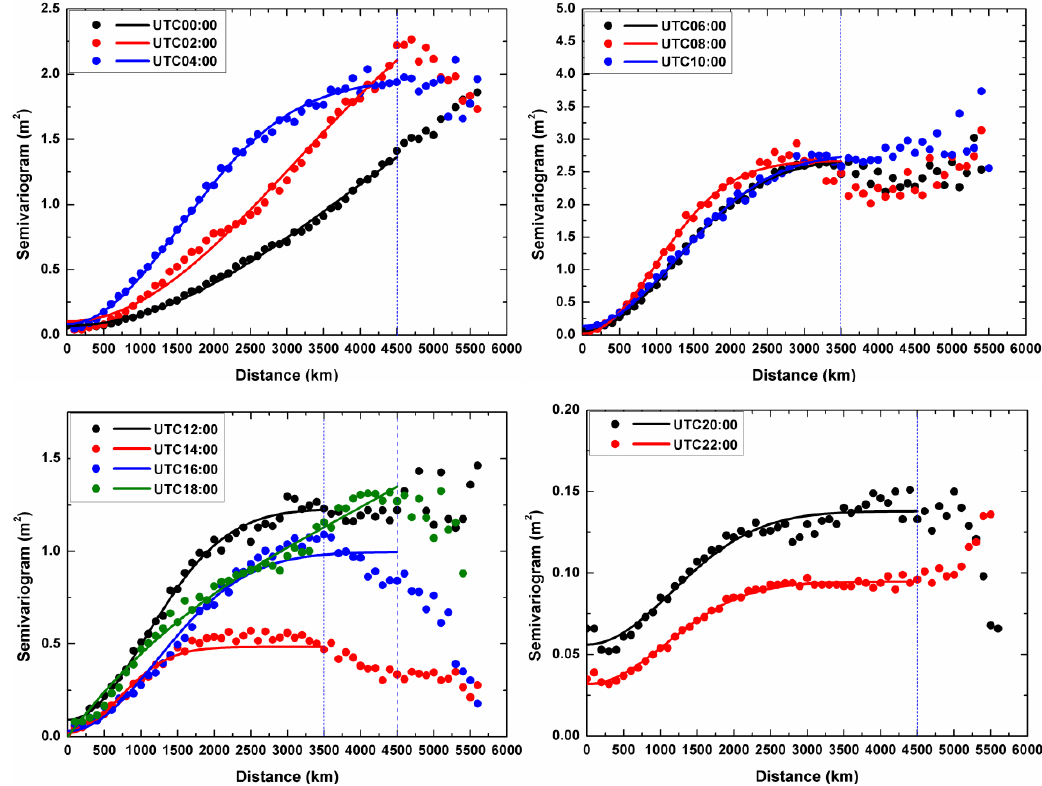
Figure 1. Experimental semivariogram (dots) and the fitting results using Gaussian function (line) at different UTC time on DOY 305, 2014. Sensors 2017 , 17 , 468 11 of 24